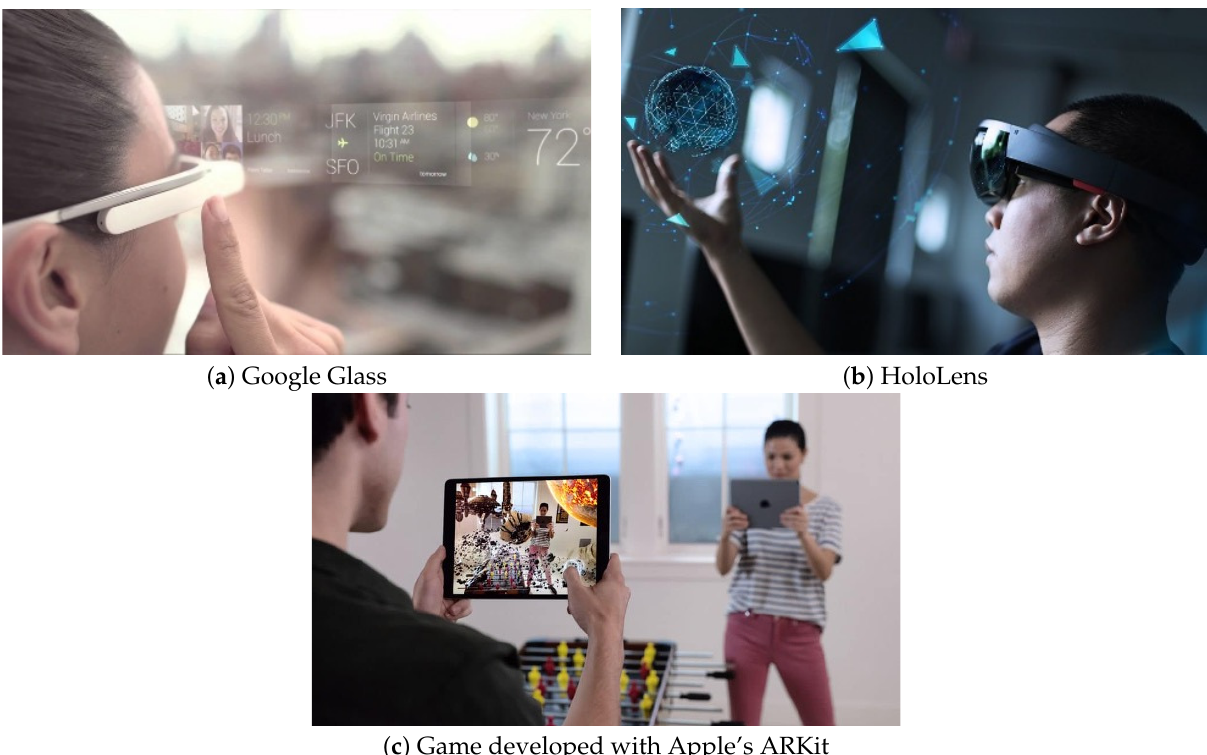
Figure 3. Augmented reality (AR) devices allow users to experience AR ( a ) or interact with the virtual world ( b ). The software development kit helps the developer implement AR-related applications on mobile devices more quickly and easily ( c